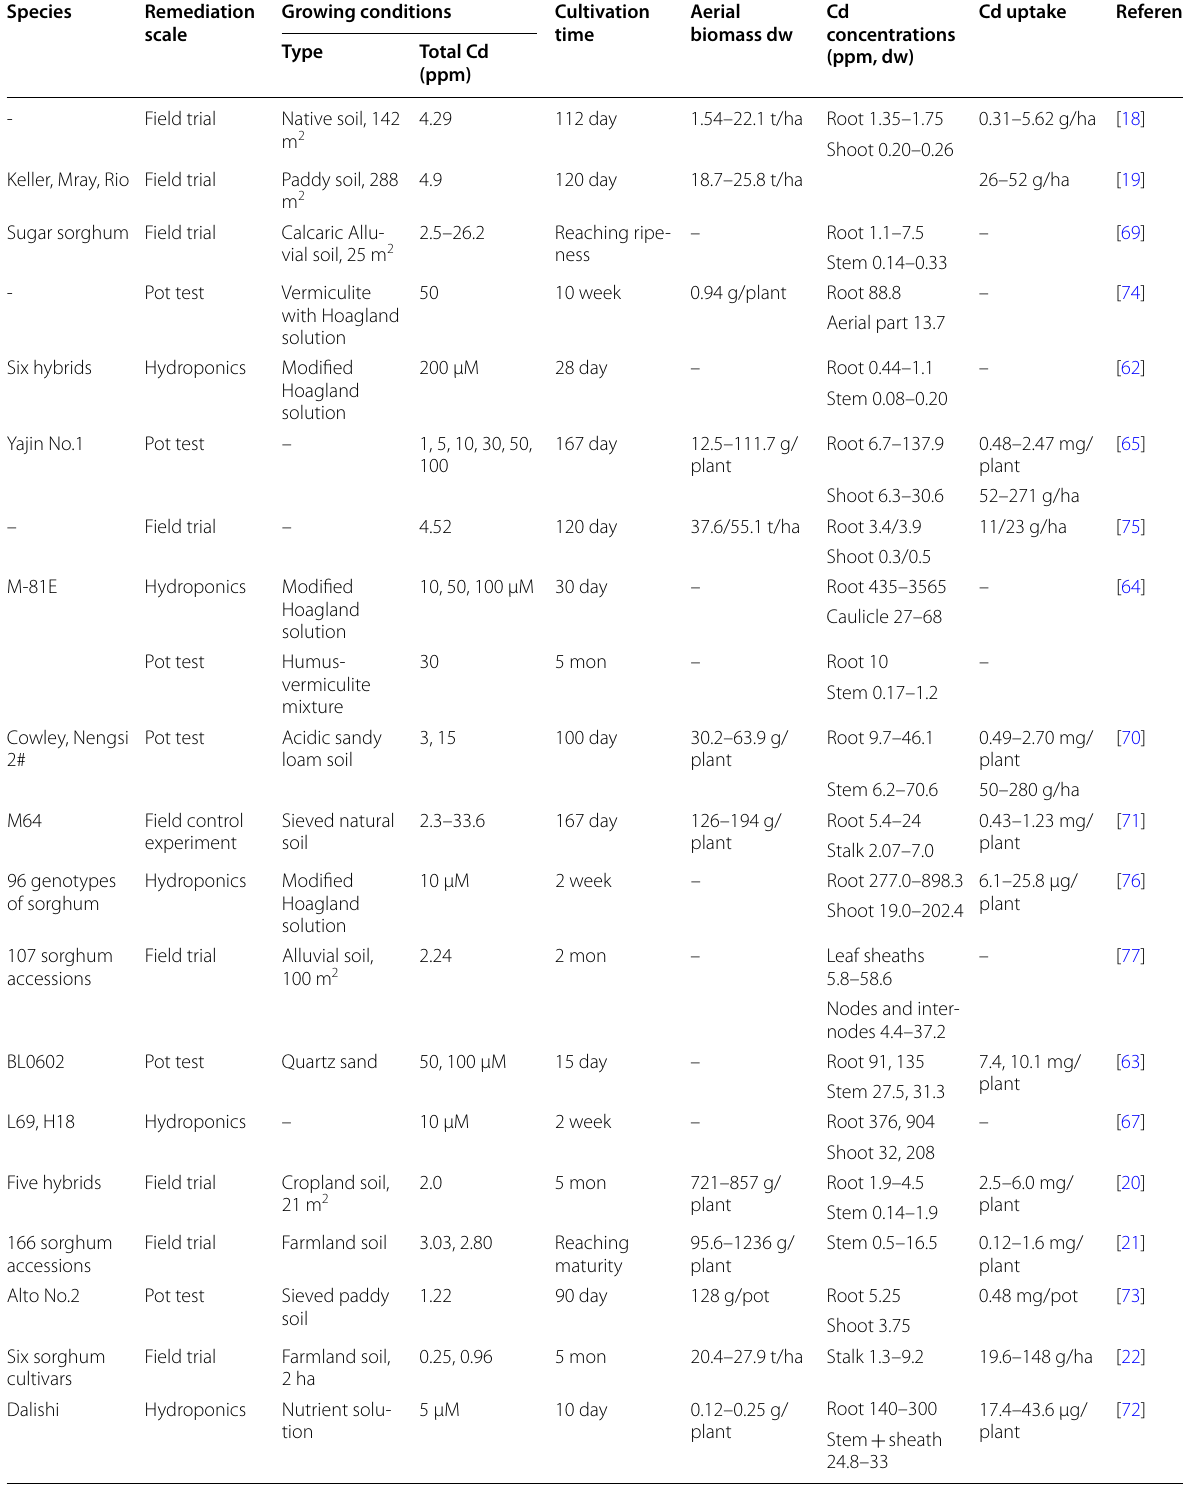
Table 1 Experiments relating to the sweet sorghum phytoremediation